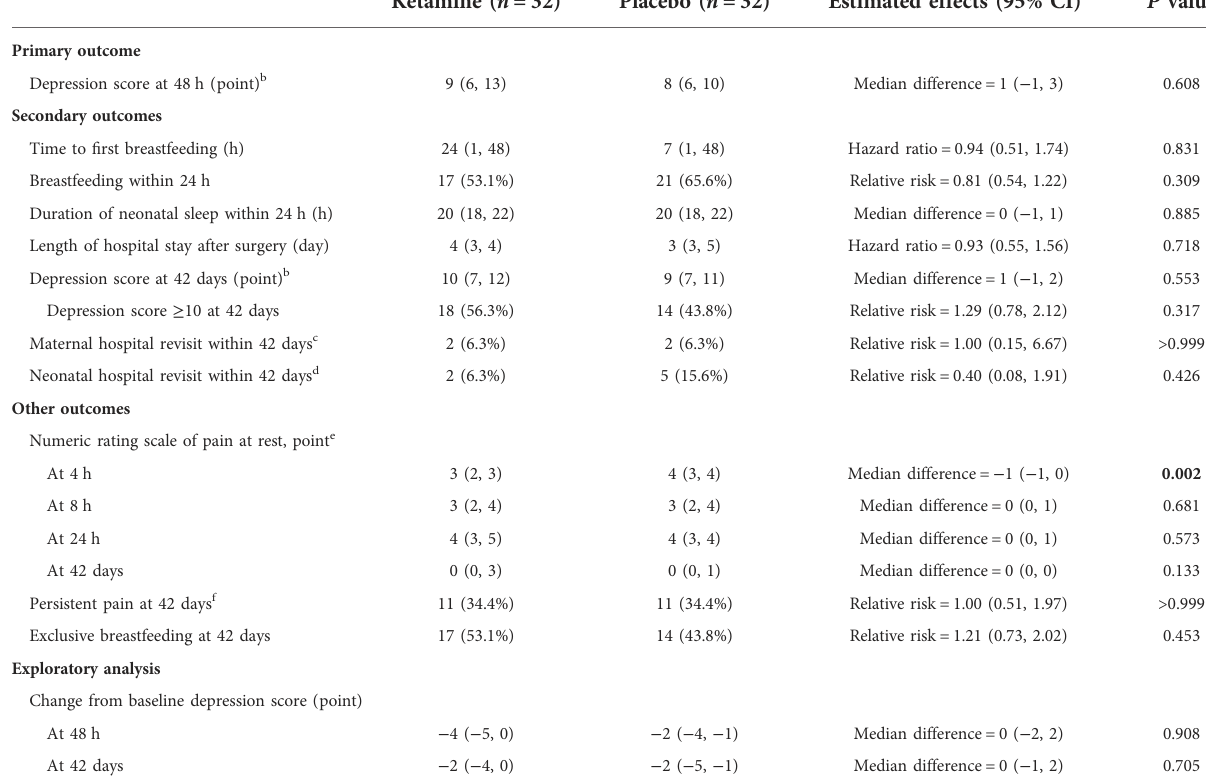
TABLE 3 Ef fi cacy outcomes.